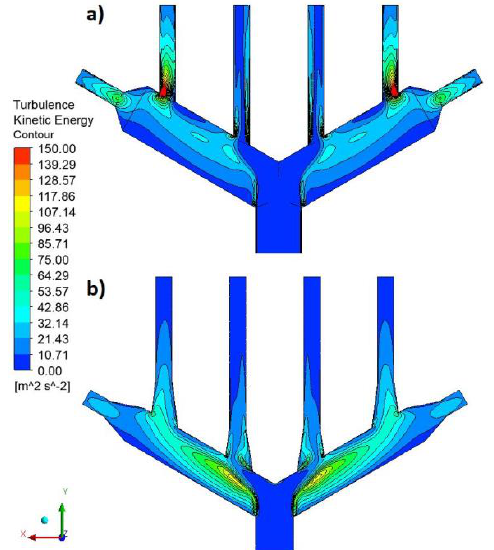
Fig. 12. Contour of the turbulence kinetic energy distribution in the reference design (a) and in the prototype (b) - the symmetry